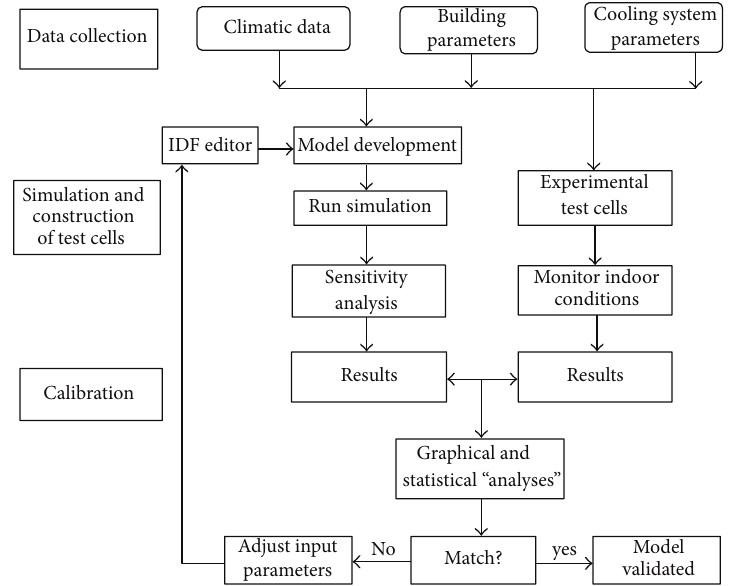
Figure 2: Flowchart of